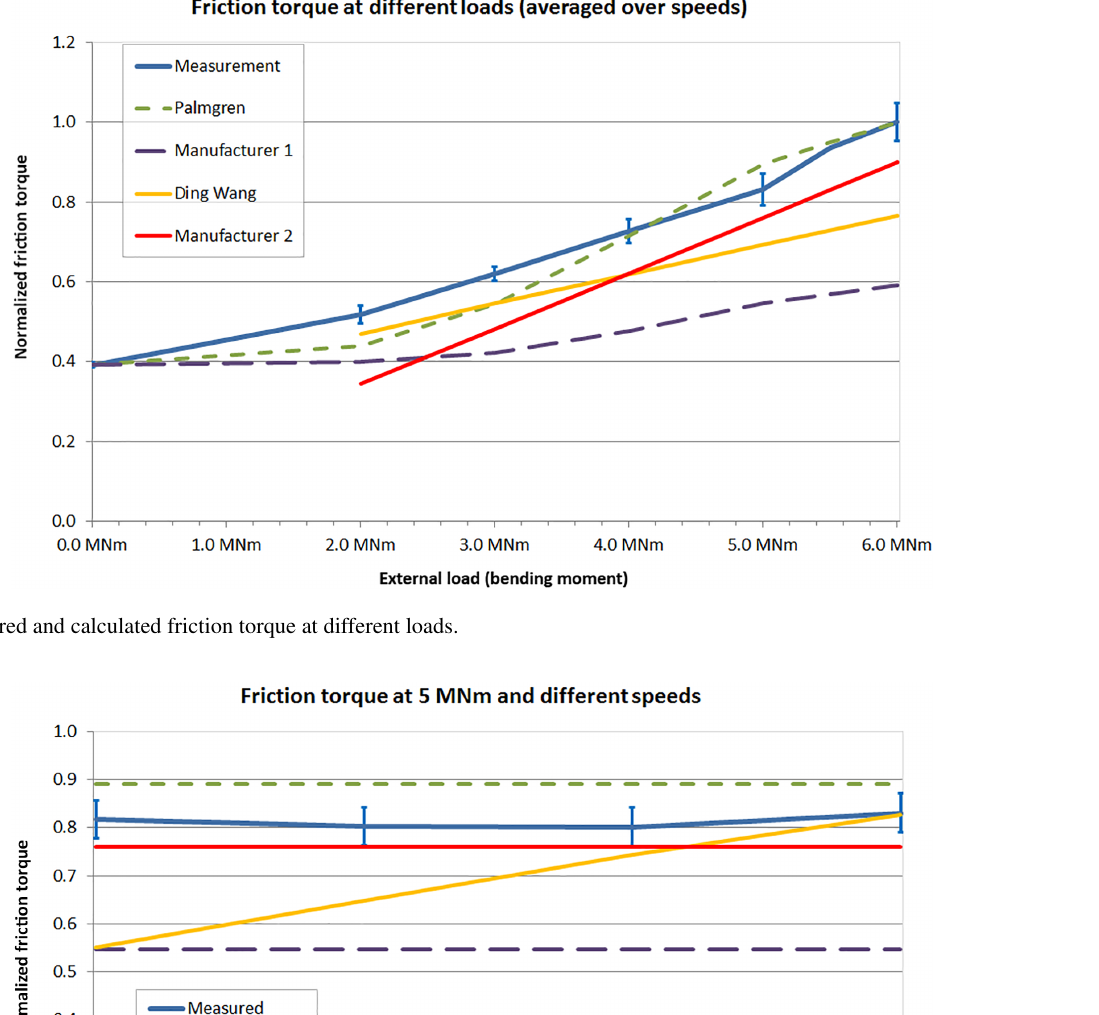
Figure 8. Measured and calculated friction torque at different speeds and a 5MN · m load.